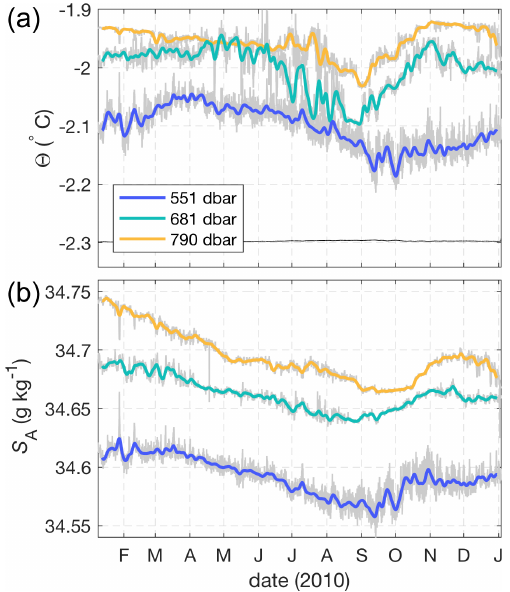
Figure 4. Time series of (a) (cid:50) and (b) S A from all three Micro- CATs. Bold lines are smoothed at 1 week, while grey lines are not smoothed. The freezing temperature (black) at upper MicroCAT salinity and interface pressure is also shown in (a)